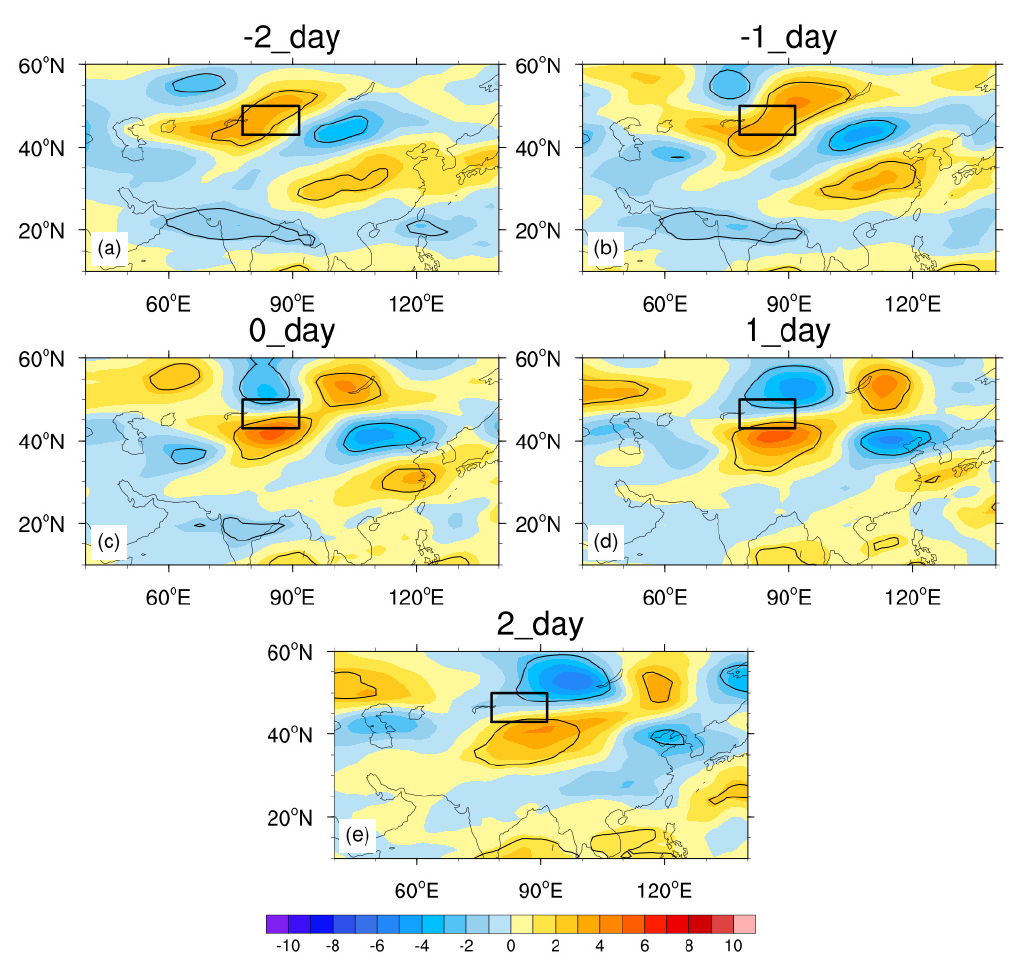
Figure 9. Composition of U200 anomaly of Type NN on the extreme precipitation day and the two days before and after ( a – e ) in the summers of 1979–2018 (Unit: m/s). The black box represents the location of the Northern Xinjiang region, and the region over the 95% significant confidence level is circled with black lines.